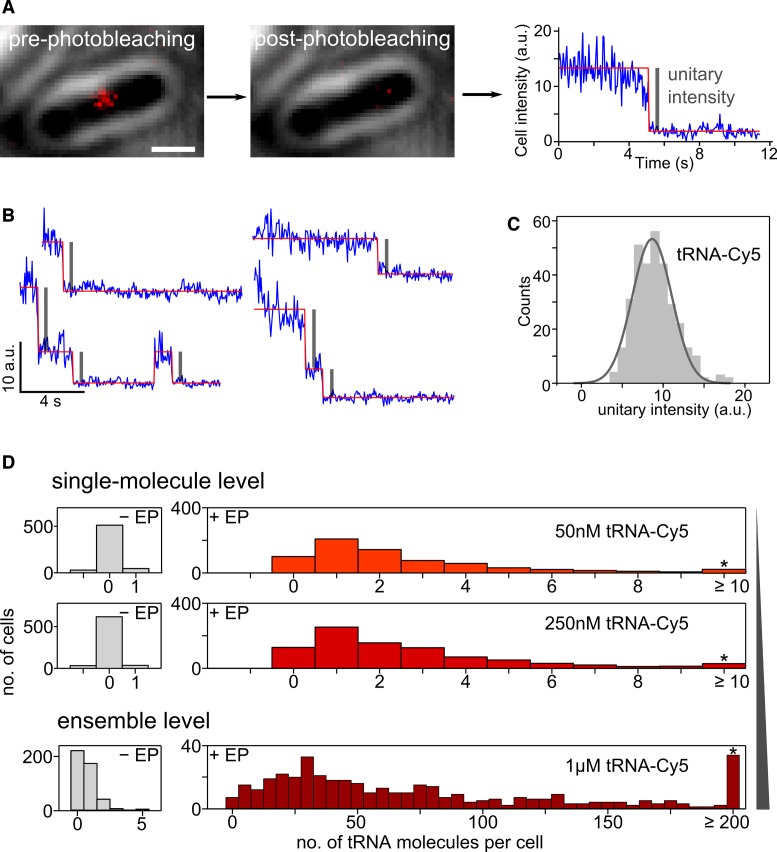
Counting and controlling the number of internalized tRNA molecules per cell. (A) Single-cell photobleaching step analysis of tRNA-Cy5 in live bacteria. Scale bar: 1 μm. (B) Photobleaching time-trace samples (blue) and Hidden–Markov Model fit (red) of single photobleaching steps corresponding to the single-molecule unitary intensity (gray bars). (C) Step height histogram (unitary intensity distribution) of tRNA-Cy5 (158 photobleaching time-traces, 324 fitted single photobleaching steps = unitary intensity) and Gaussian fit centered at (8.7 ± 2.4) a.u. corresponding to Cy5 brightness of (7500 ± 2100) photons/s. (D) Counting the number of internalized tRNA-Cy5 molecules per cell at different concentrations of labeled tRNA-Cy5 in cell suspension before electroporation. Cells are loaded with 1–10 tRNA molecules when adding 50 nM tRNA-Cy5 (mean: 1.4 molecules per cell, median: 0.9) and up to 250 nM tRNA-Cy5 (mean: 1.5 molecules per cell, median: 1.0) in the cell suspension before electroporation, which is an ideal regime for single-molecule studies. Cells are loaded with about 100 tRNA molecules per cell (mean: ∼140, median: ∼100, Supplementary Figure S5 for tRNA-Cy3 and tRNA-Cy5.5) at 1 μM tRNA-Cy5 initial concentration before electroporation.